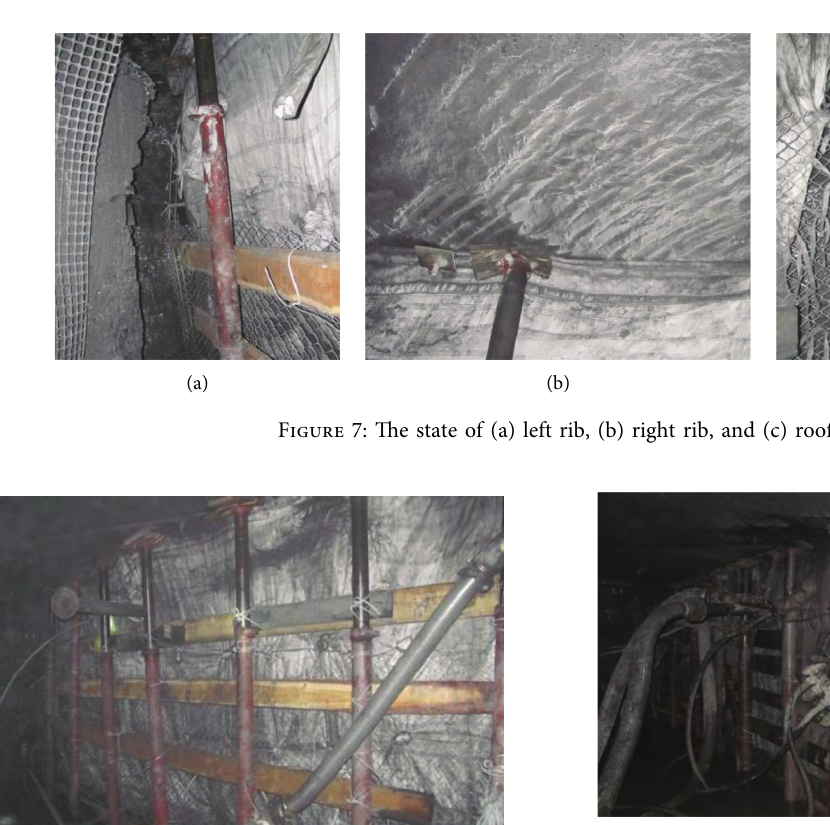
Figure 9: Mold bag filling